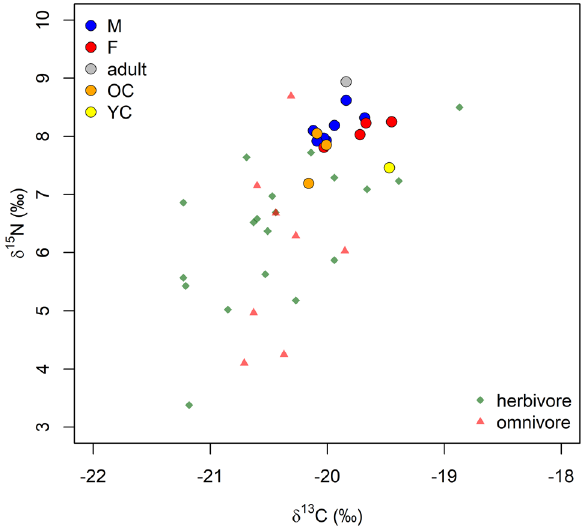
Figure 3. Fermo δ 13 C and δ 15 N result values for human samples according to sex and age-at-death. δ 13 C and δ 15 N baseline values (i.e. omnivores and herbivores) derive from palaeo(environmental) studies conducted on the closest available site to Fermo that is known in the scholarly literature, namely Coppa Nevigata 23 . Yellow dots: young children (YC = 1–5 years of age); orange dots: older children (OC = 5–10 years of age); blue dots: adult males (M, M(?)); red dots: adult females (F, F(?)); grey dots: adults